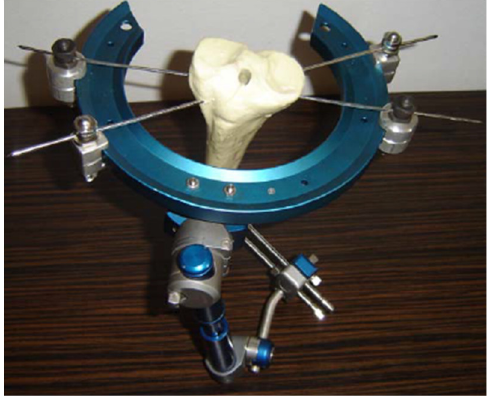
Figure 5. Locking Plate internal implant system.